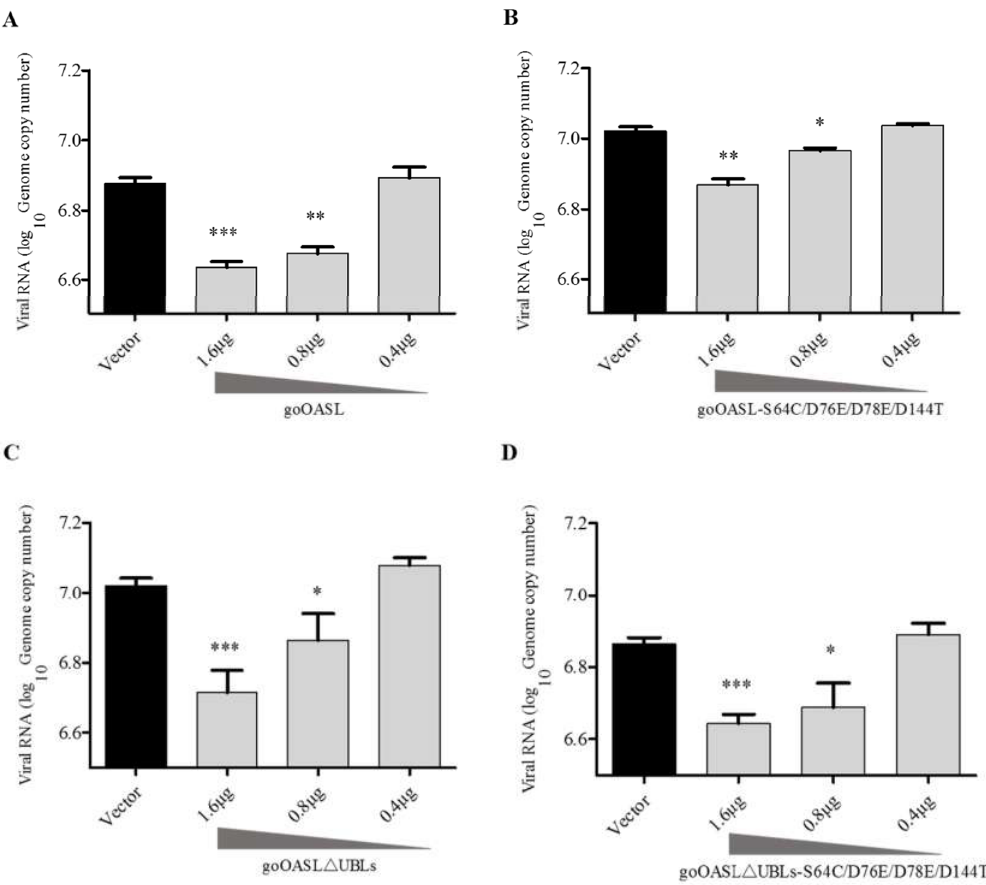
Figure 4. GoOASL and its mutant proteins exhibited antiviral activity against DTMUV in DEFs in a dose-dependent manner. GoOASL-overexpressing cells ( A ), goOASL-S64C/D76E/D78E/D144T- overexpressing cells ( B ), goOASL∆UBLs-overexpressing cells ( C ), goOASL∆UBLs- S64C/D76E/D78E/D144T-overexpressing cells ( D ) were transfected with different doses of